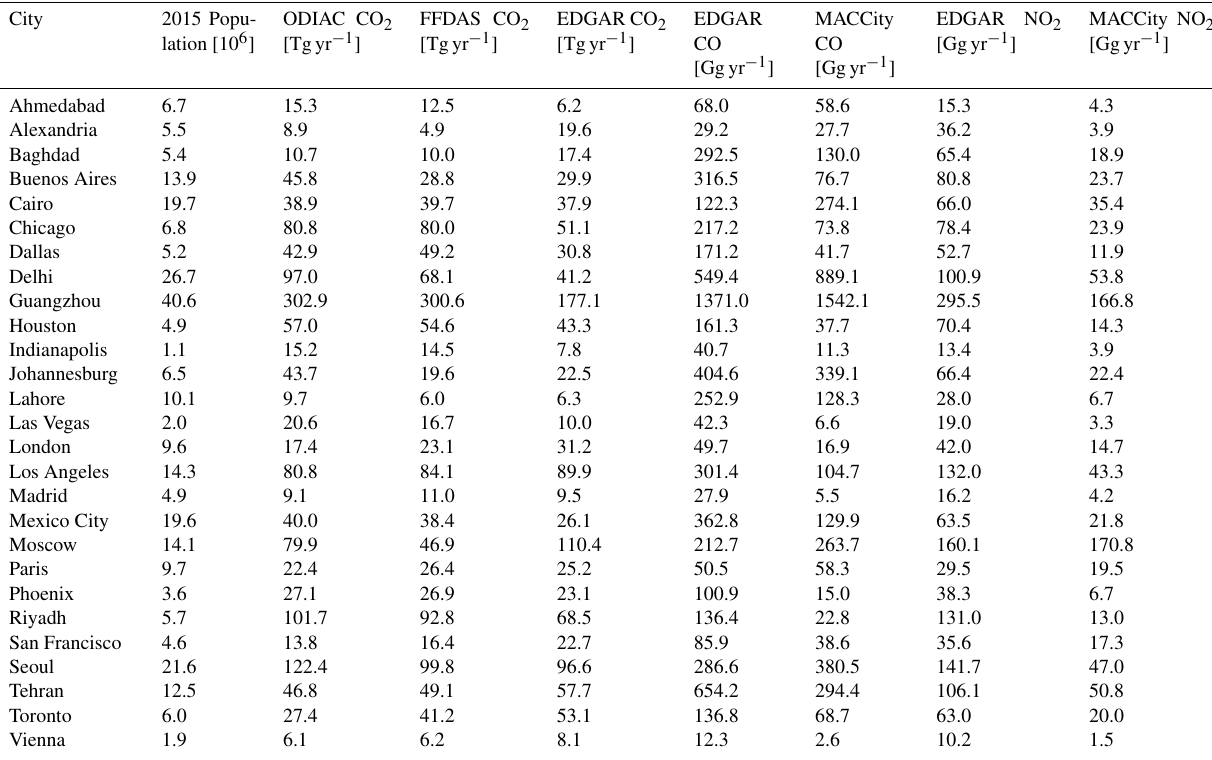
Table 1. Summary of inventory-based emissions estimates for all the cities that were considered. Gridded emissions are summed across the extent of the GHS polygon for each city. For the ODIAC and MACCity inventories, which are provided at a monthly temporal resolution, the estimate is the mean across all 12